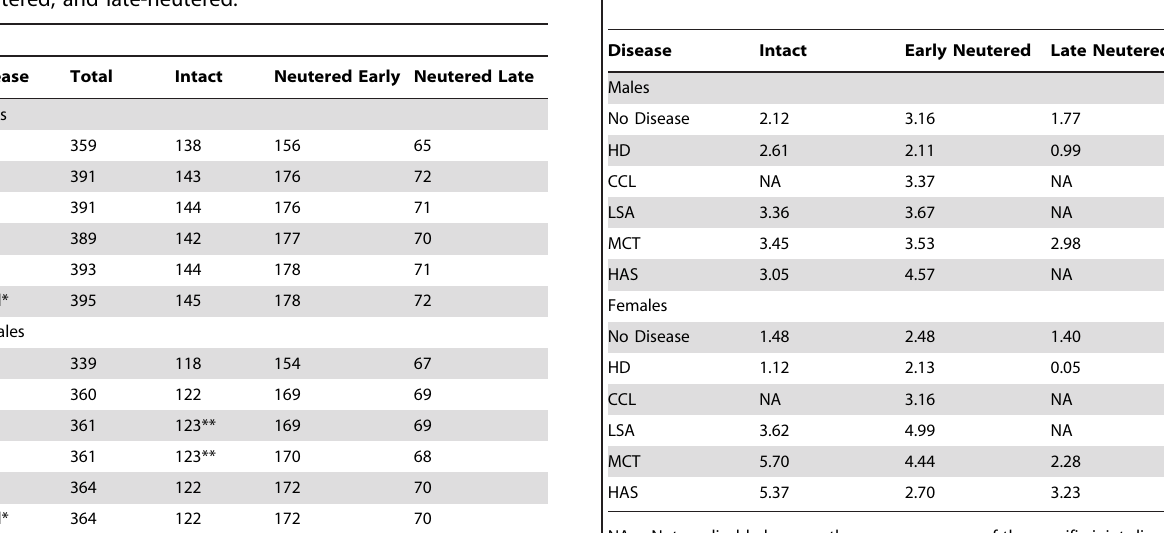
Table 3. Mean follow-up times for male and female Golden Retrievers (1–8 years old) admitted to the Veterinary Medical Hospital, University of California, Davis, from 2000–2009 by disease status for each neuter